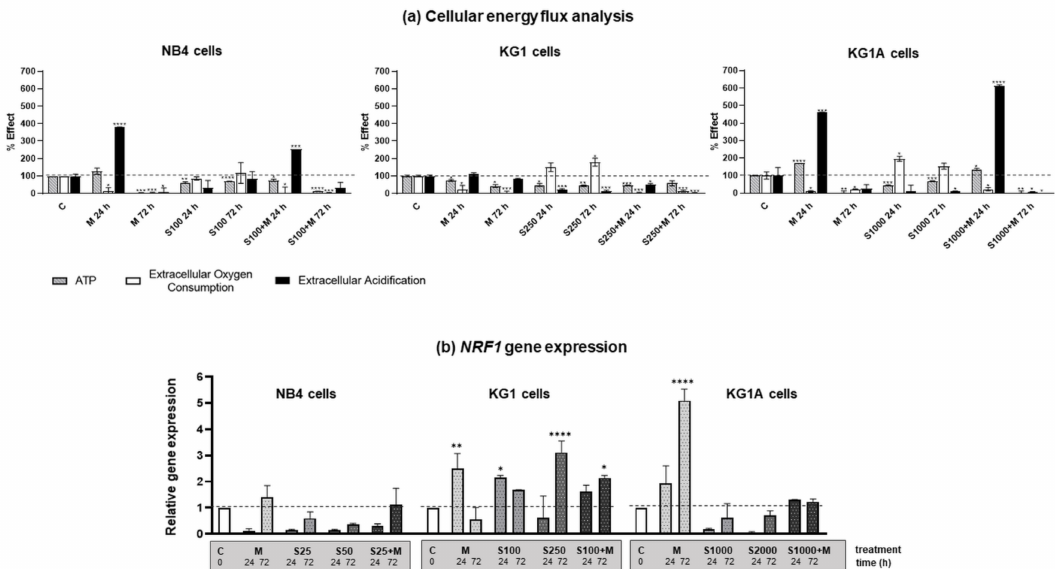
Figure 2. Cellular energy flux after treatment with metformin and MCL-1 inhibitor S63845. ( a ) Cellular energy flux for NB4 cells (treated with 100 nM S63845, 10 mM metformin and combination of 100 nM S63845 + 10 mM metformin), KG1 cells (treated with 250 nM S63845, 10 mM metformin and combination of 250 nM S63845 + 10 mM metformin), as well as KG1A cells (treated with 1000 nM S63845, 10 mM metformin and combination of 1000 nM S63845 + 10 mM metformin) shown as a percentage relative to untreated control cells. Comparative measurements after 24 and 72 h of incubation were taken with Extracellular Oxygen Consumption Assay (ab197243; seeded at 500,000 viable cells per well; white columns), Glycolysis Assay [Extracellular acidification] (ab197244; seeded at 500,000 viable cells per well; black columns) and Luminescent ATP Detection Assay Kit (ab113849; seeded at 75,000 viable cells per well; striped columns). ( b ) Gene expression changes of nuclear respiratory factor 1 (NRF1) after treatments were measured using RT-qPCR ∆∆ Ct method. HPRT1 gene expression was used for normalization; results are presented as relative changes in comparison to untreated cells; results are mean ± S.D. ( n = 3). Note: * denotes significant difference between treated vs. control cells with p < 0.05, ** denotes significant difference with p < 0.01, *** denotes significant difference with p < 0.005 and **** denotes significant difference with p < 0.0001, as evaluated using 1-way ANOVA with Dunnett post hoc